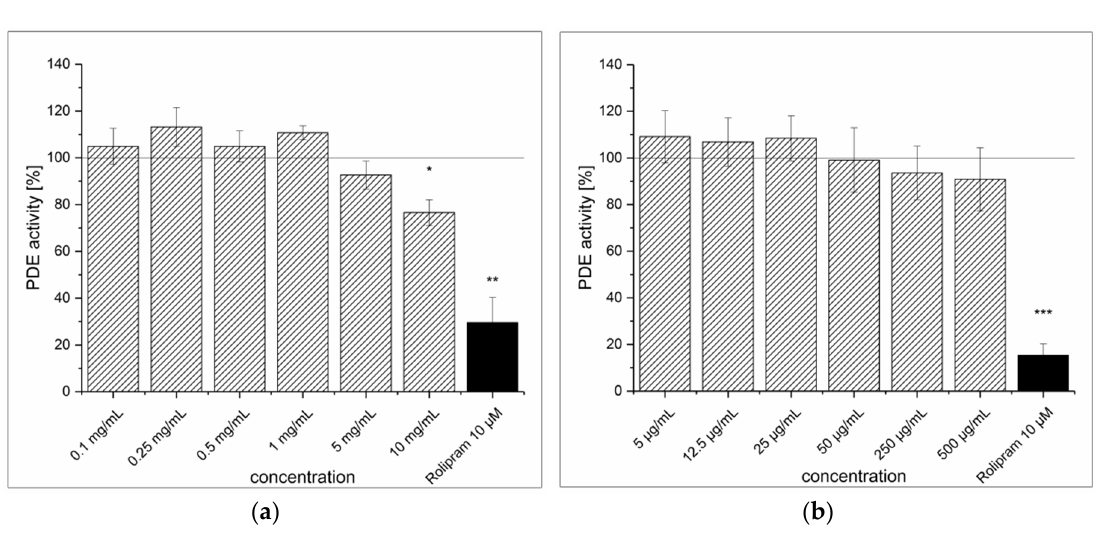
Figure 2. cAMP ‐ specific phosphodiesterase (PDE) activity following incubation with strawberry tree fruit extract (SFE) ( a ) and purified arbutin ( b ). Data are presented as the mean ± standard deviation of three independent experiments. The significance of differences between sample and control was assessed with a Student’s t ‐ test. Confidence intervals: * p < 0.05; ** p < 0.01; *** p < 0.001.